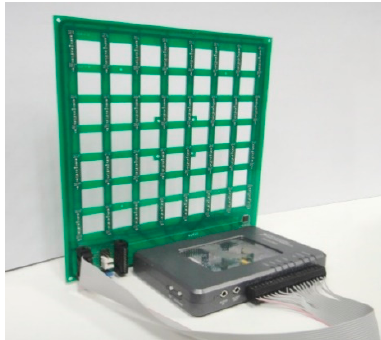
Figure 2. Array module with myRIO and MEMS array board.